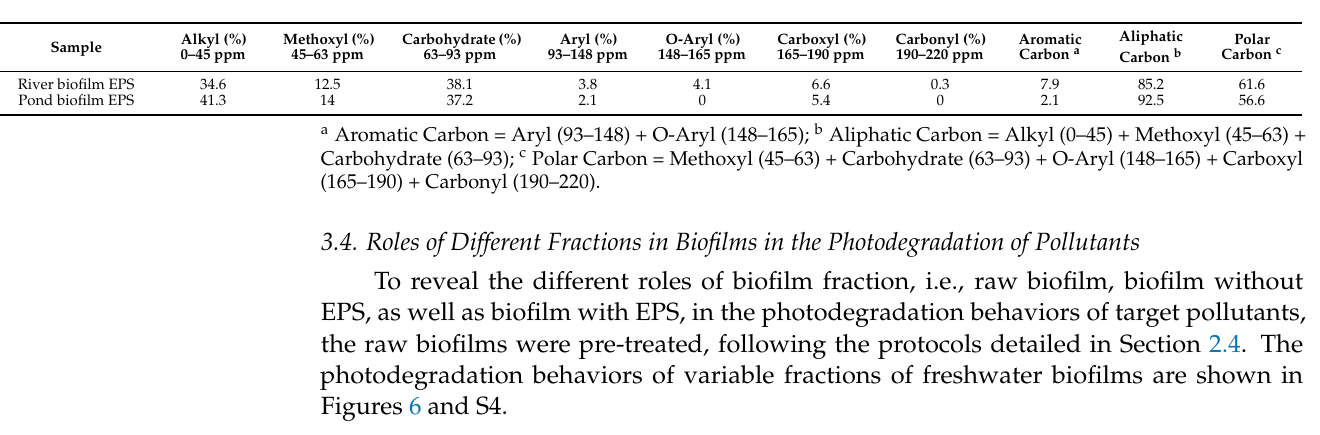
Table 2. Integration results of solid-state 13 C nuclear magnetic resonance of biofilm samples.